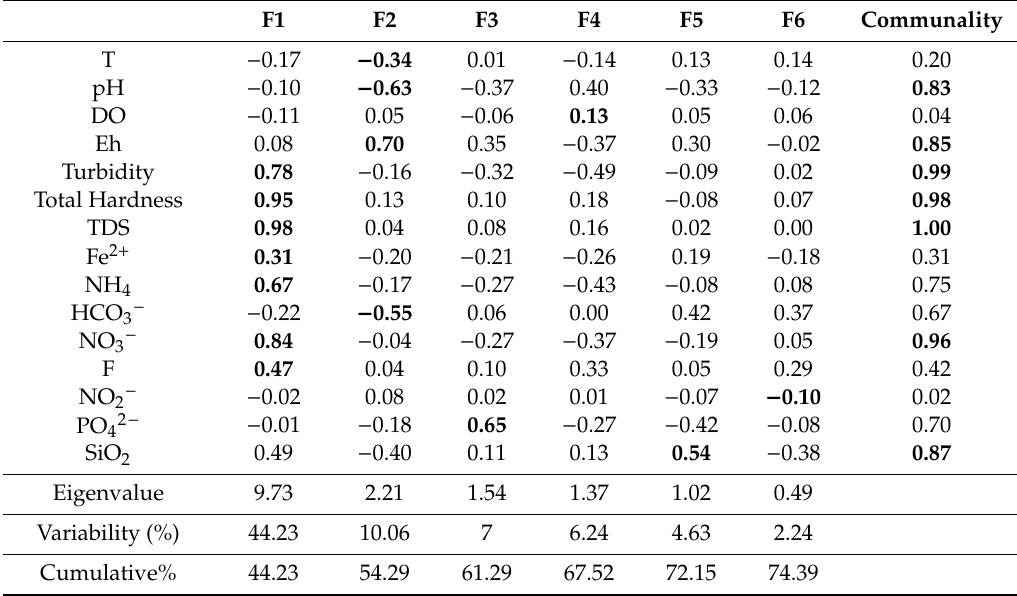
Table 4. Factor analysis of the studied groundwater quality